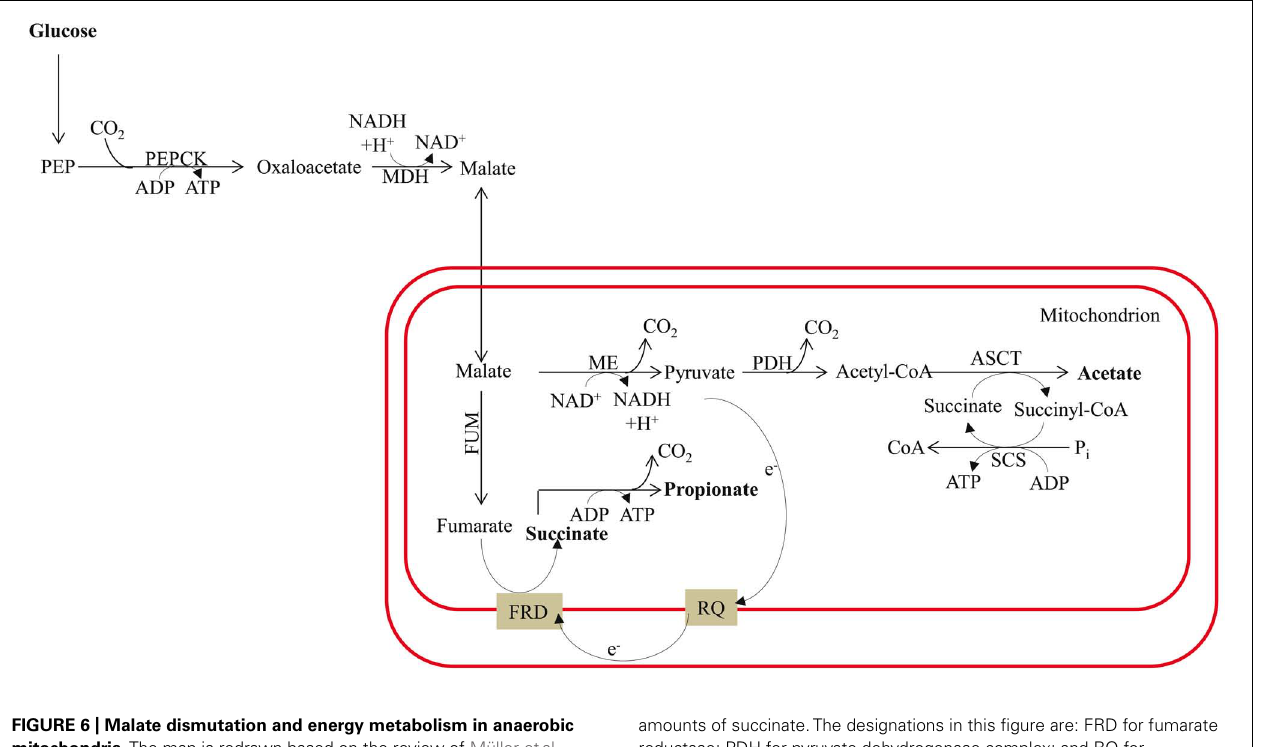
amounts of succinate.The designations in this figure are: FRD for fumarate reductase; PDH for pyruvate dehydrogenase complex; and RQ for rhodoquinone. See previous figure for other